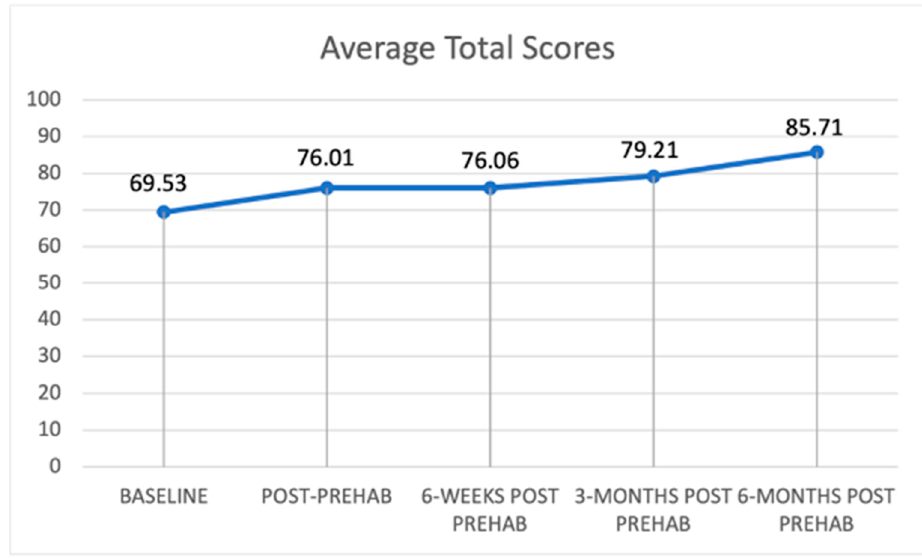
Figure 1. Trajectory of self-reported health-related quality of life.